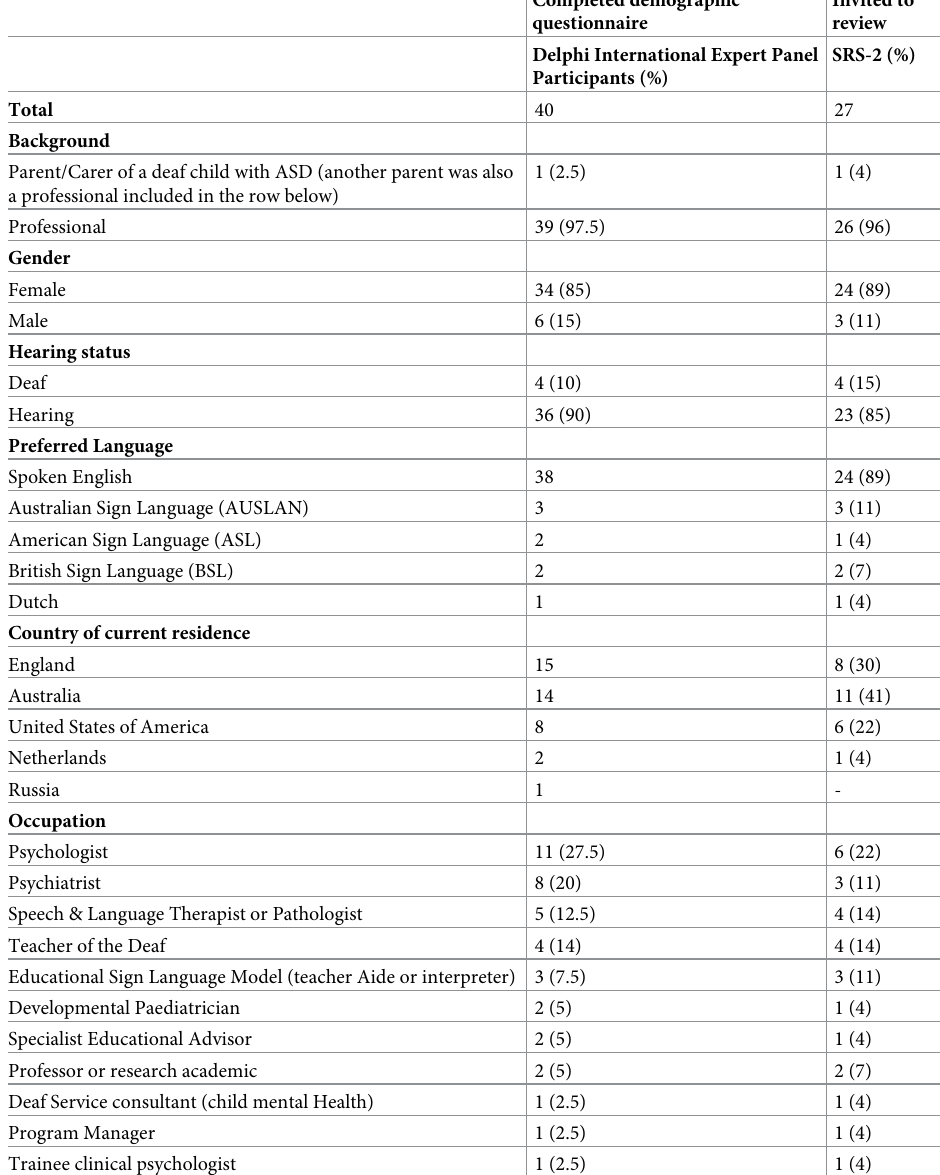
Table 1. Demographic characteristics for the experts recruited to the Delphi Consensus